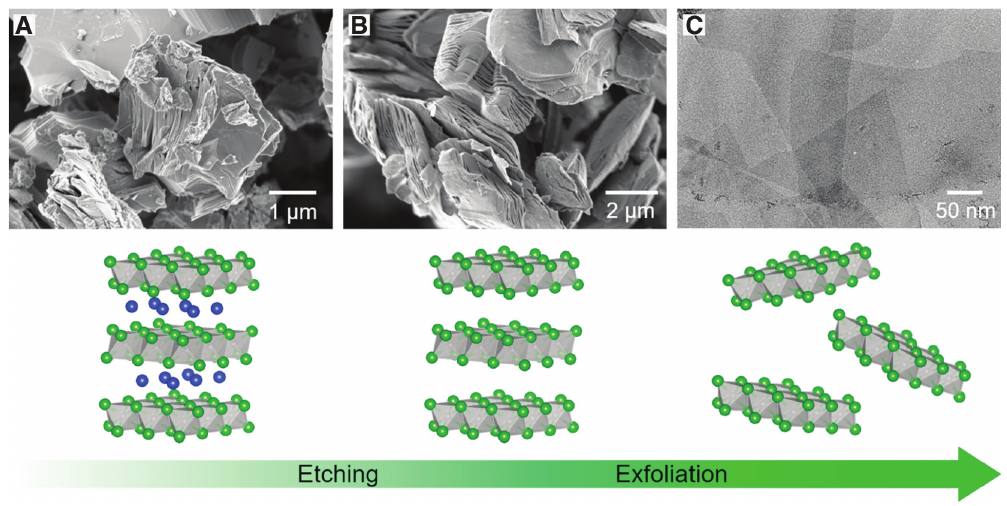
Figure 2: Synthesis pathway of 2D MXene